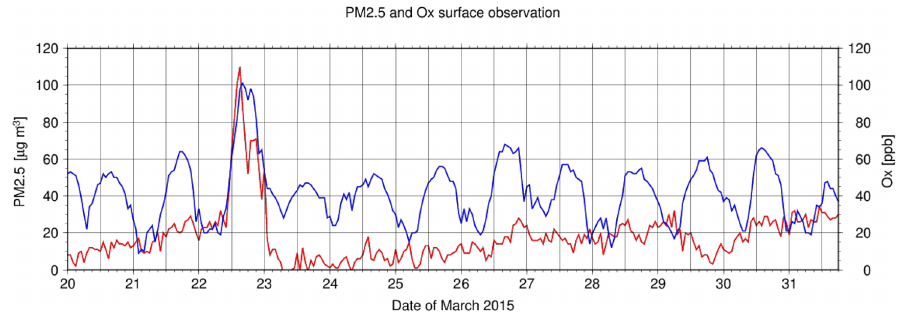
Figure 4. Hourly (JST) data of surface PM 2 . 5 (red line) and O x (blue line) measured by the Saga Prefectural Environmental Research Center for 20–31 March 2015. The volume mixing ratio of O x was considered to be that of ozone.